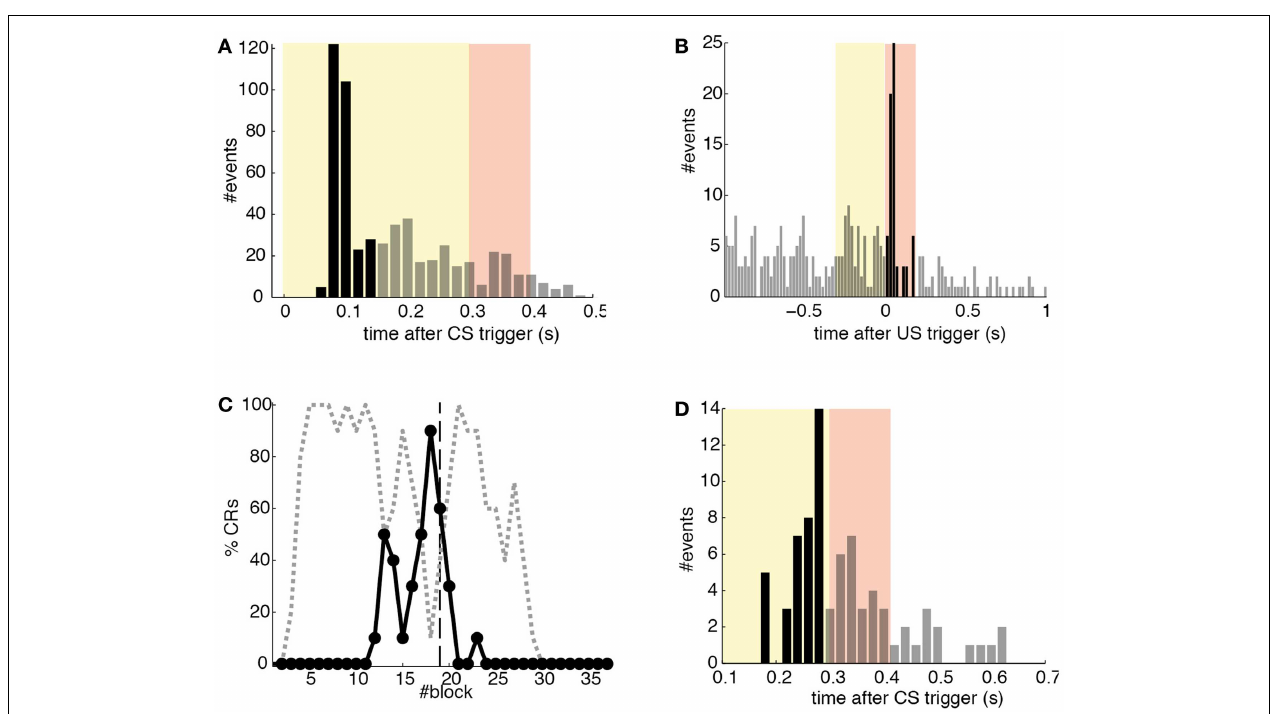
during acquisition and extinction (solid line) are shown. CRs that were not triggered at least 20ms ahead of the US-trigger appear as late CRs (dashed line). Each block contains 10 trials. (D) Timing of CRs. Histogram of the CRs: well-timed (black bars) and late ones (gray bars). CS period (yellow area) and US period (pink area) are indicated.The information is extracted from trials 118 to 190.